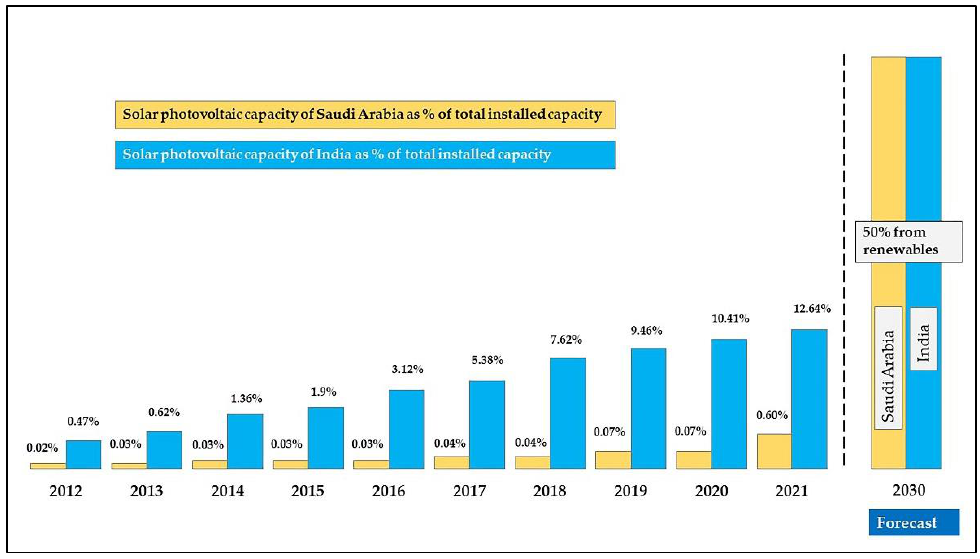
Figure 2. Percentage of solar photovoltaic capacity as a part of total installed capacity from all electricity generation sources in Saudi Arabia and India during the period 2012–2021 and forecast for 2030 (author compilation).